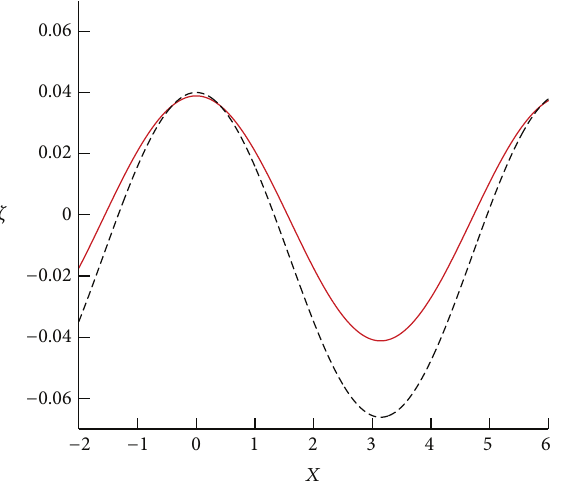
Figure 2: Comparison of our present 3rd-order surface elevation 𝜁 with those obtained by the perturbation method. Solid line: perturbation-series solution; dashed line: homotopy-series